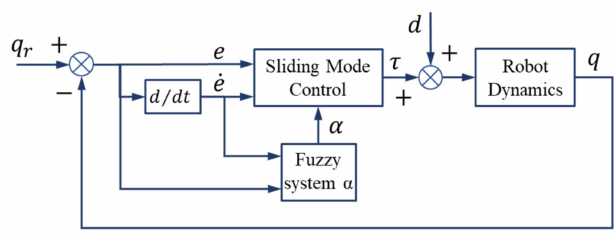
Figure 6. FSMC with adaptive slope of α .